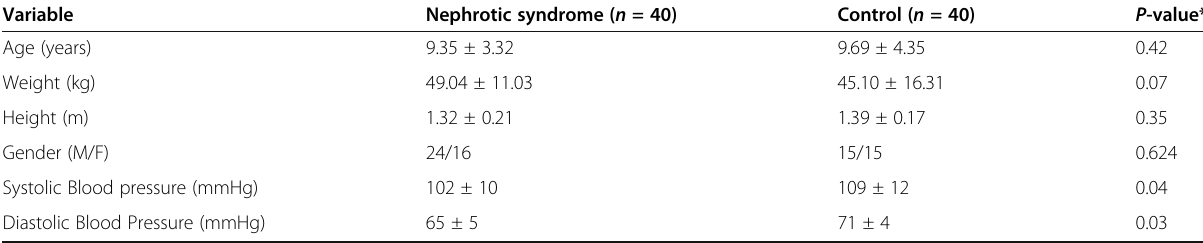
Table 1 Demographic criteria of cases and controls